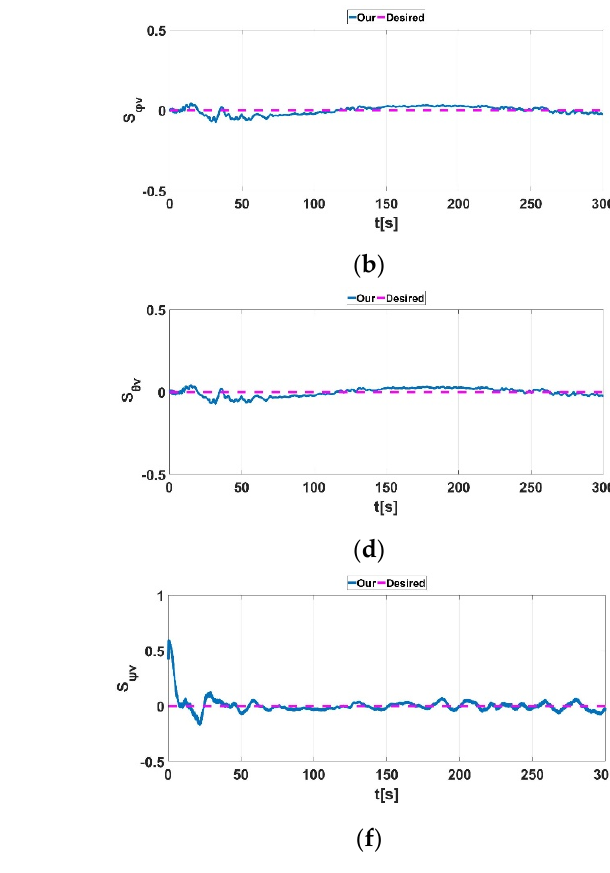
Figure 15. Outer − loop PID sliding surface 𝑺 𝒗 (cid:3556) . ( a ) 𝑆 𝑣𝑥 ; ( b ) 𝑆 𝑣𝜑 ; ( c ) 𝑆 𝑣𝑦 ; ( d ) 𝑆 𝑣𝜃 ; ( e ) 𝑆 𝑣𝑧 ; ( f ) 𝑆 𝑣𝜓 .